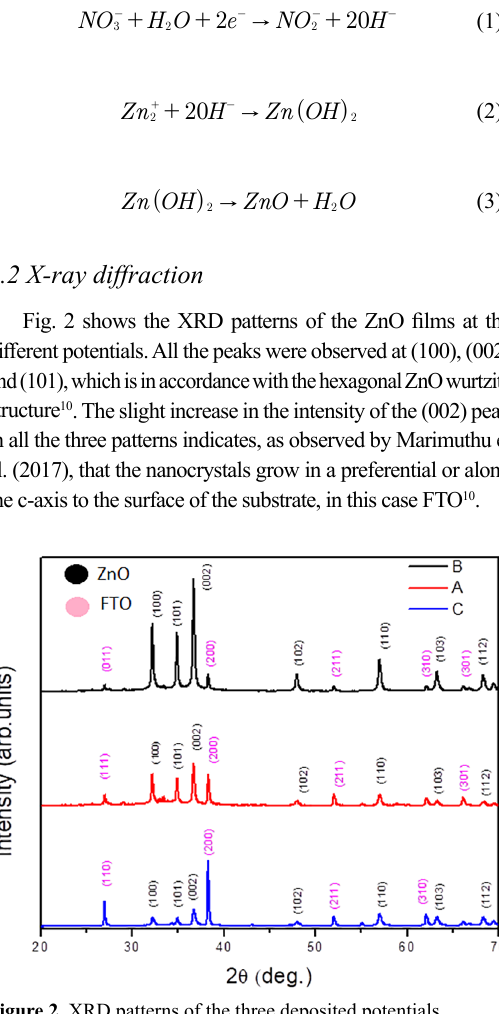
Figure 2. XRD patterns of the three deposited potentials